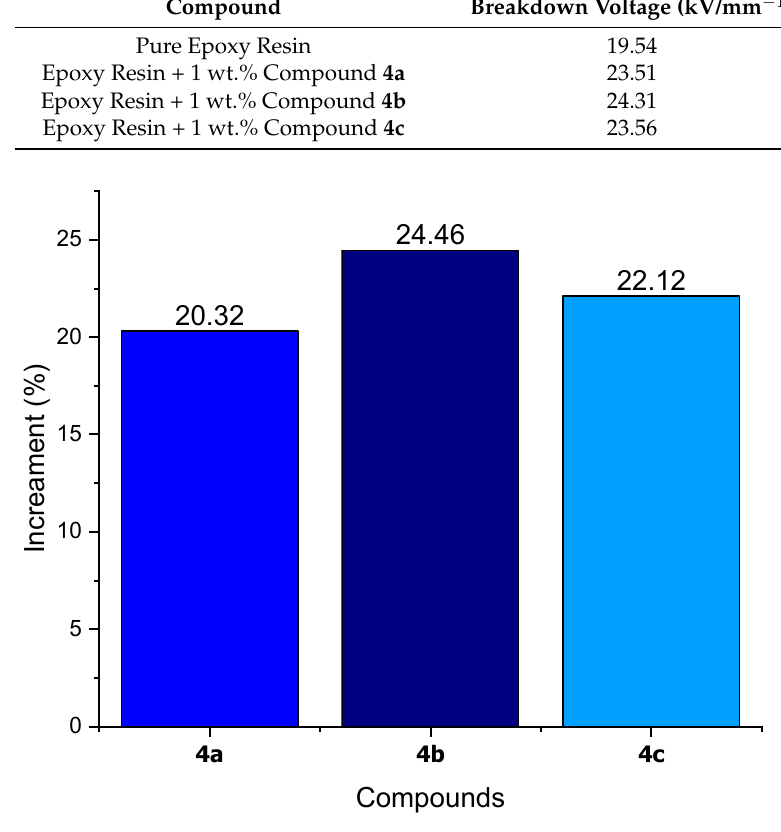
Figure 8. Increment of dielectric breakdown strength of compounds 4a – c .